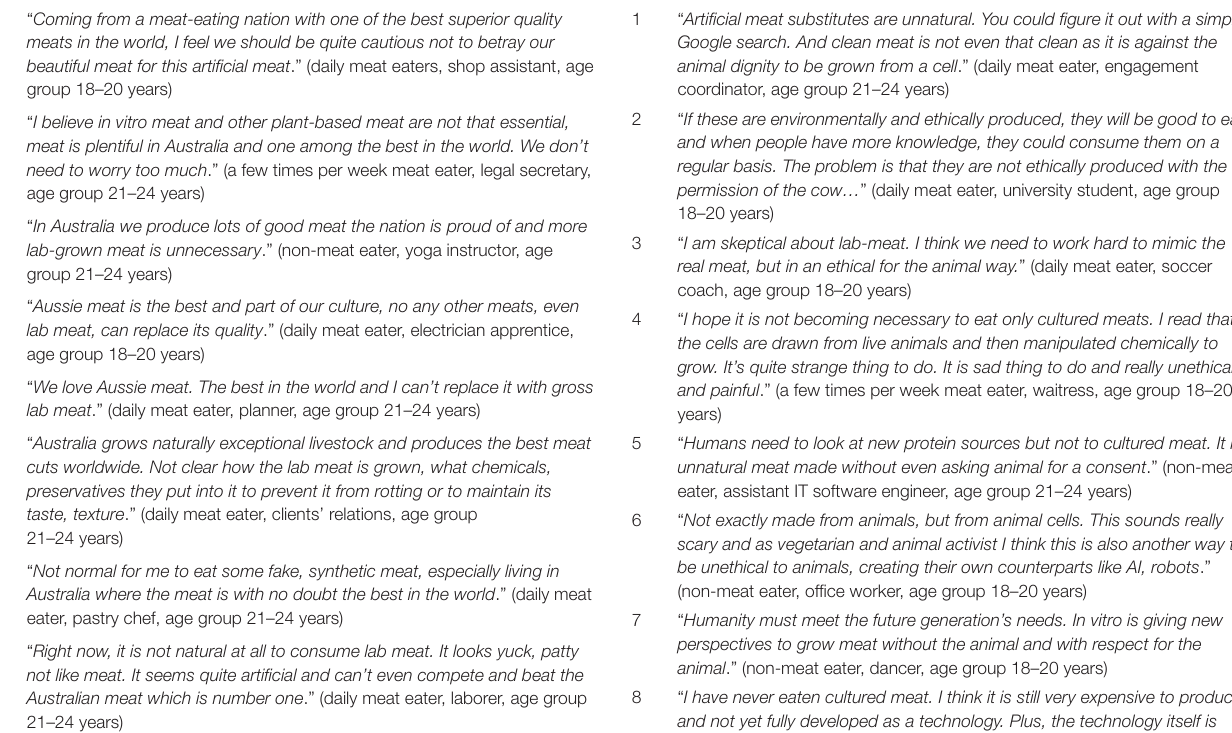
TABLE 9 | Animal dignity concerns by Sydney Gen